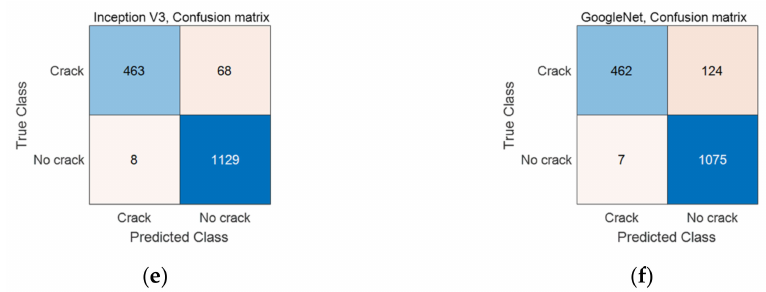
Figure 11. ( a , c , e ) Accuracy and ( b , d , f ) loss curves for training and validation process of the studied CNNs, together with their corresponding confusion matrix of test dataset.